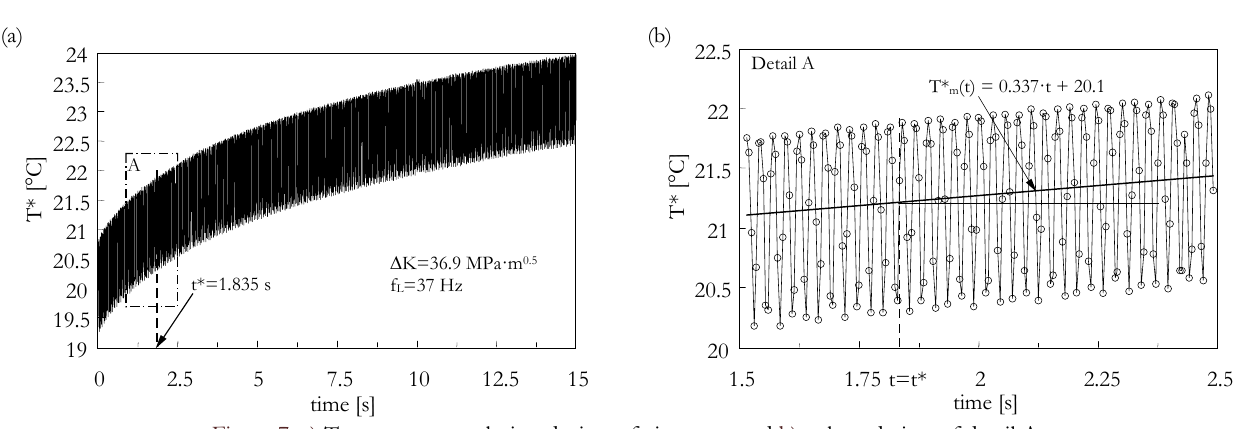
Figure 7: a) Temperature evolution during a fatigue test and b) enlarged view of detail A D